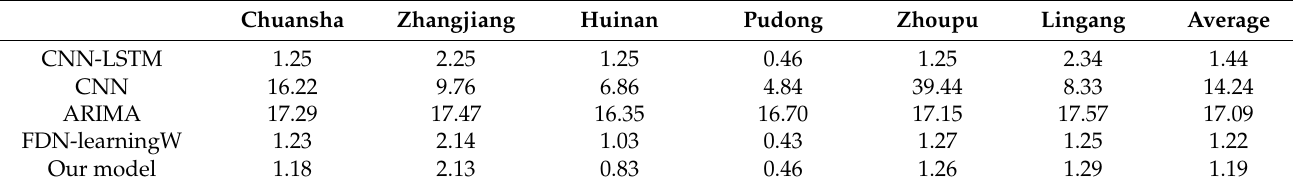
Table 3. Performance comparison of different models on MAE.